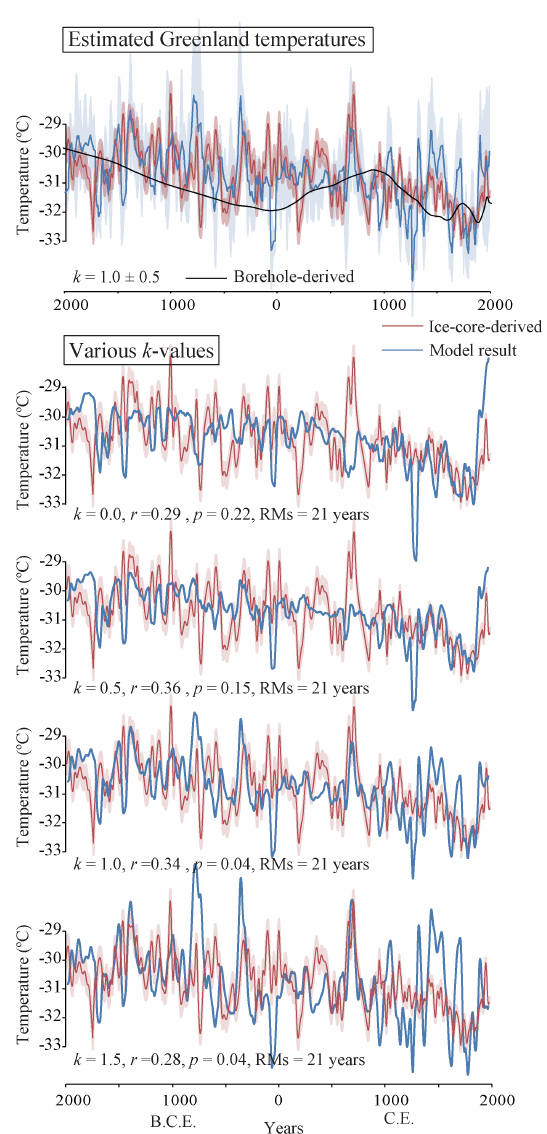
Fig. 6. Modelled and observed Greenland temperatures with various k values. Top panel: ice-core-derived (red) (Kobashi et al., 2011) and modelled (blue) Greenland temperatures with 2 σ error bands. We calculated Greenland temperatures from the model outputs of 70–80 ◦ N average temperatures using the relationship in Eq. (2). The scaling coefficient k is estimated to be 1 ± 0.5 (2 σ ). X GT and s GT are from the ice-core-derived Greenland temperature (Kobashi et al., 2011). Uncertainties for TSI in Eq. (2) were derived from the standard deviation of three detrended and normalized TSI records (Fig. 5c). Then, uncertainties in the modelled Greenland tempera- ture were calculated by the theory of error propagation. Black line at the top panel is the Greenland Summit temperature reconstruc- tion from the GRIP borehole temperature profile (Dahl-Jensen et al., 1998). Lower panels: modelled Greenland temperatures with different k values, compared to the ice-core-derived Greenland tem- perature (Kobashi et al.,